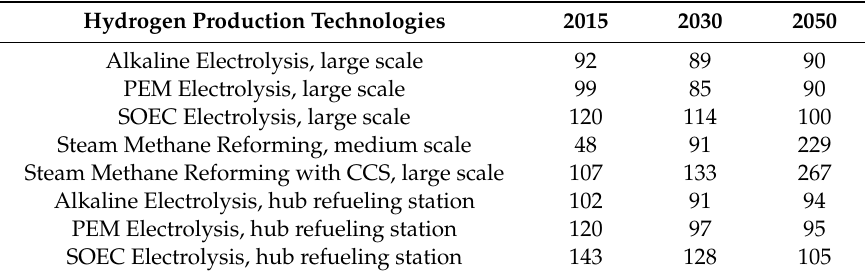
Table 1. Levelized unit cost of hydrogen in EUR / MWh-H 2